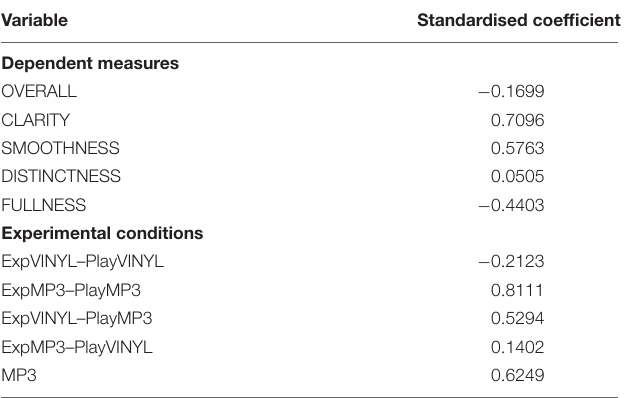
of the standardised coefficients, as presented in Table 1